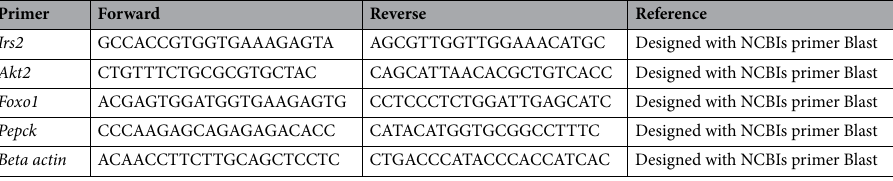
Table 2. Primers